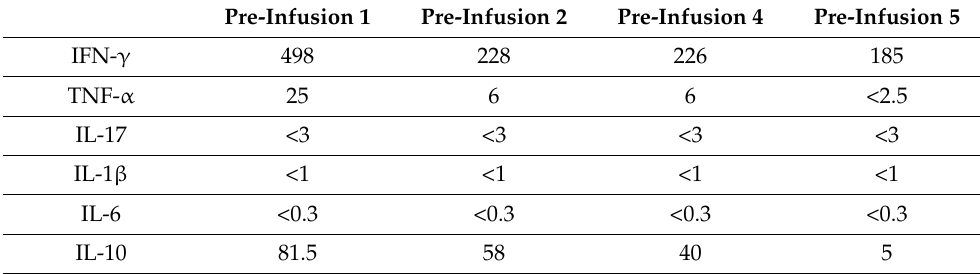
Table 6. Plasma cytokine levels. Results are expressed as